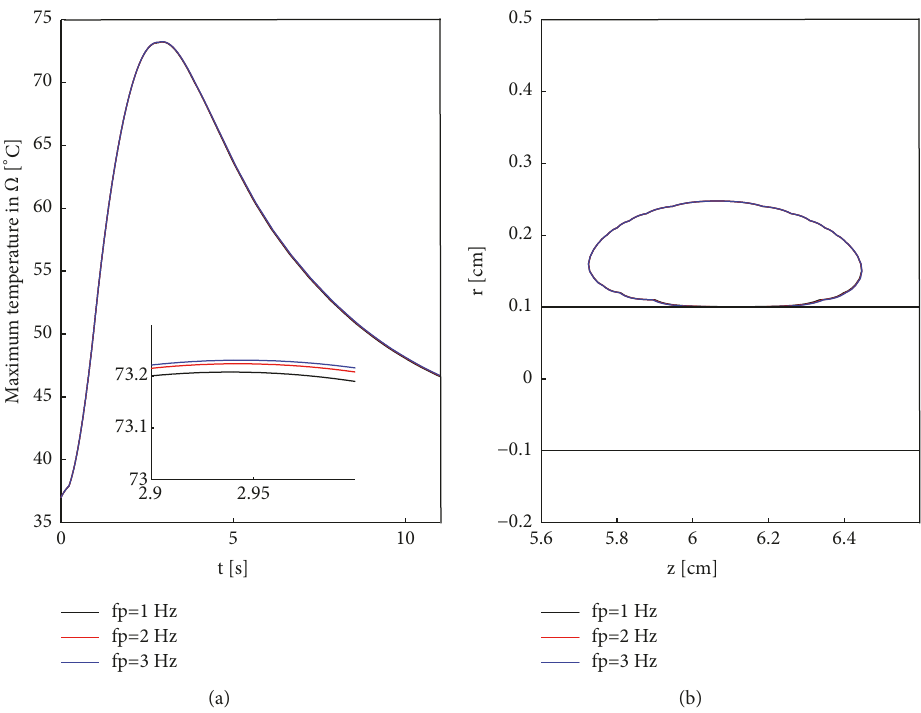
Figure 4: Effect of heartbeat frequency 𝑓 𝑝 on HIFU hyperthermia: (a) maximum temperature in space 𝑟, 𝑧 ∈ Ω versus time; (b) thermal lesion region. Here, 𝑝 0 = 1.5 × 10 5 𝑝𝑎 , 𝑟 0 = 1𝑚𝑚 , 𝑑 = 1.5 𝑚𝑚 , 𝑢 𝑎 V 𝑒 = 5 𝑐𝑚/𝑠 , 𝑓𝑎𝑐 = 0.5 , 𝑡 ℎ = 1 𝑠